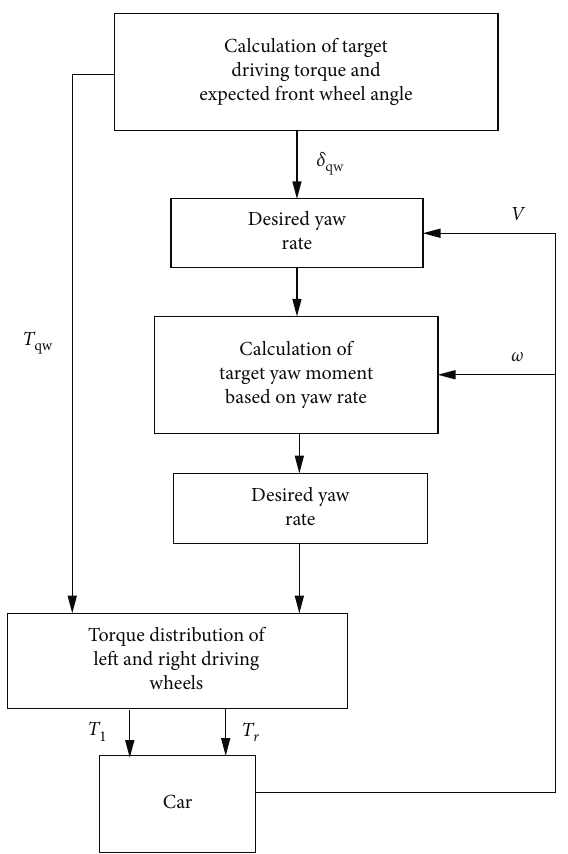
Figure 5: The driving torque distribution strategy based on the desired yaw